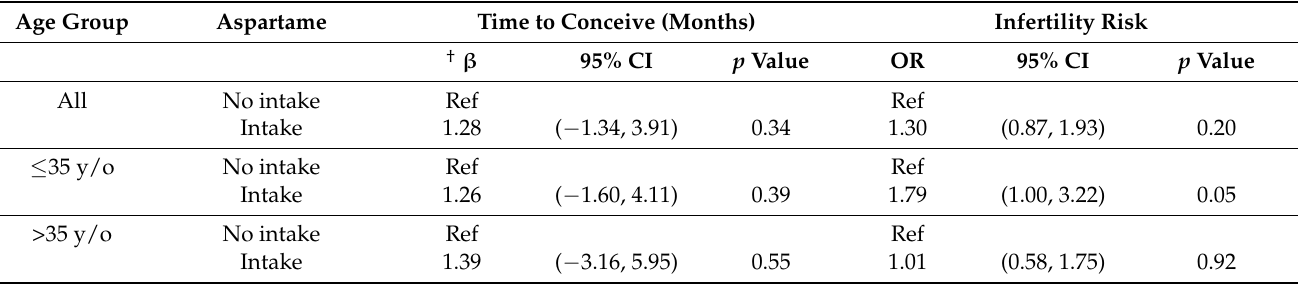
Table 2. Association of aspartame consumption with the risk of infertility, TMINC (n = 845).